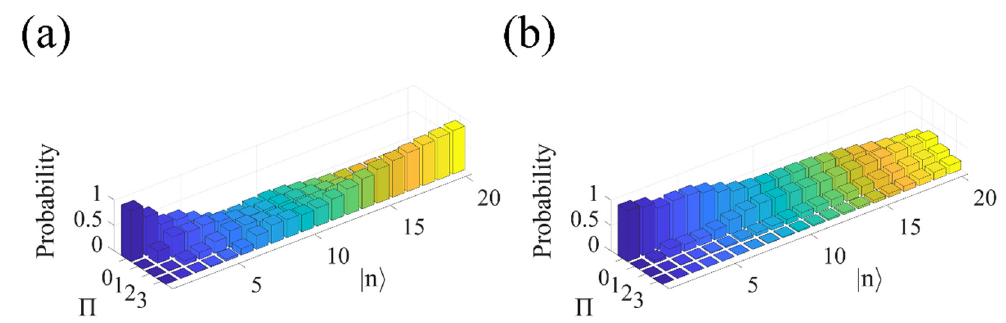
Figure 4. POVM elements of MPPC at ( a ) 791 nm; ( b ) 523 nm. The POVM are presented in three dimensions and truncated at twenty for clarity.